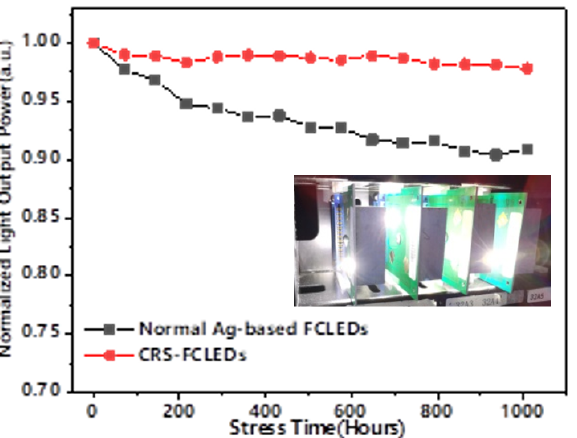
Figure 6. Optical degradation of CRS-FCLED and normal Ag-based FCLED during high-tempera- ture operation life test. (inset: Reliability testing system).